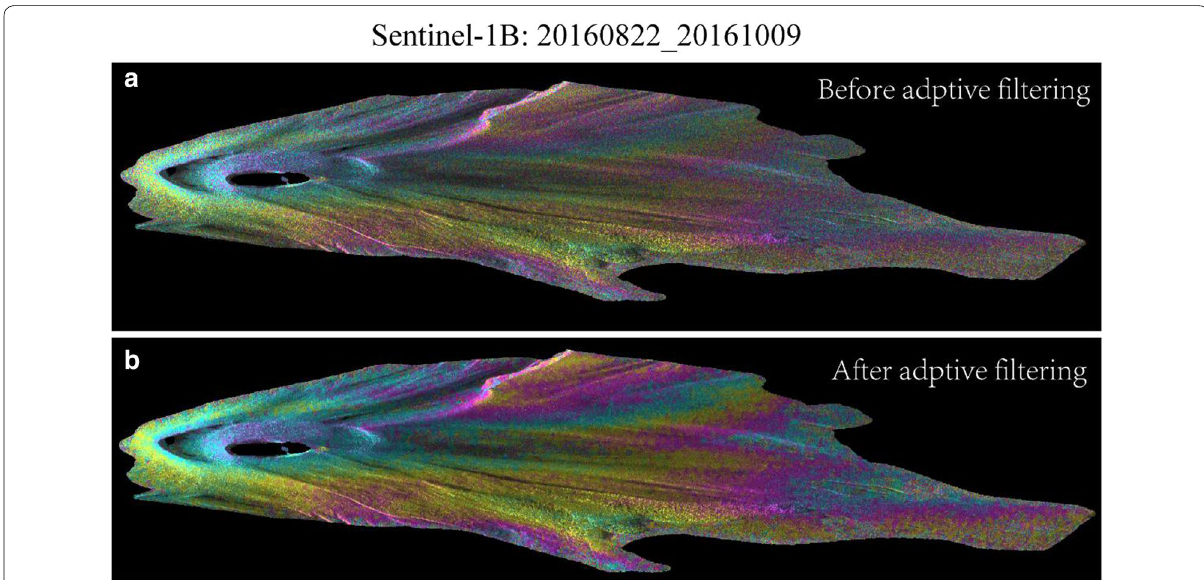
Fig. 5 The Sentinel-1B interferogram 20160822–20161009 before ( a ) and after ( b ) adaptive multi-looking based on the statistically homogeneous pixels (SHPs). Note the images are in radar